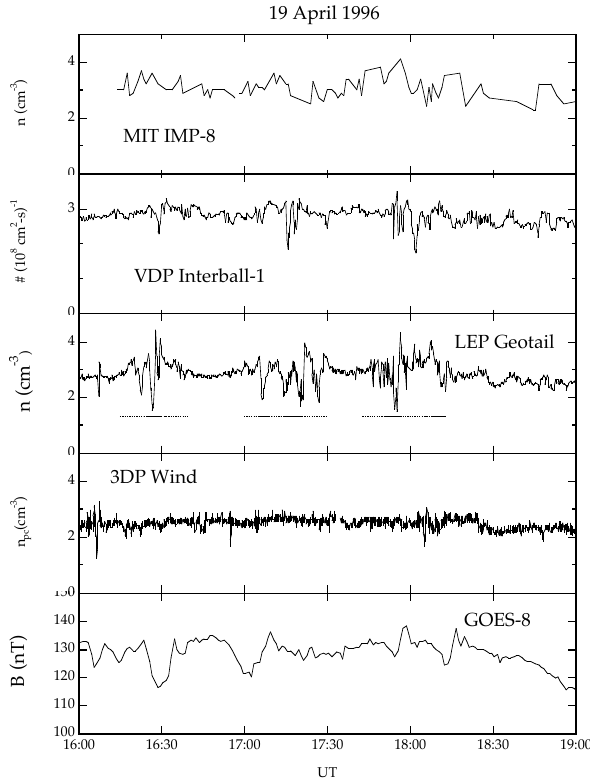
Fig. 10. A comparison of the solar wind density observed by IMP-8, the solar wind flux (nV) observed by Interball-1, the solar wind den- sity observed by Geotail, the solar wind density observed by Wind, and the dayside geosynchronous magnetic field strength observed by GOES-8 from 16:00 to 19:00 UT on 19 April